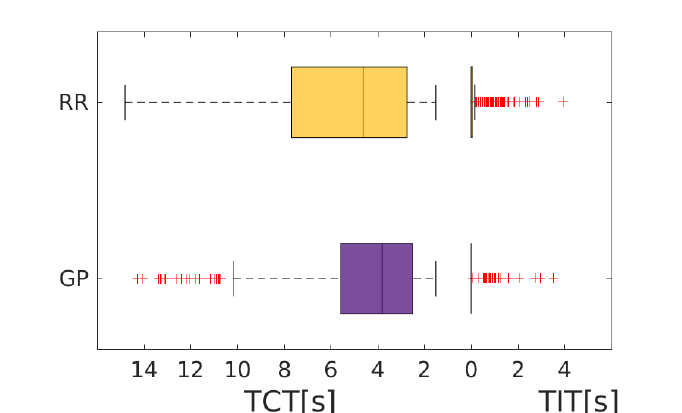
Figure 7. Comparison of the time to complete task (TCT) and the time in the target (TIT) between Gaussian process regression (GPR) and ridge regression (RR), in the case of successful and failed tasks, respectively.